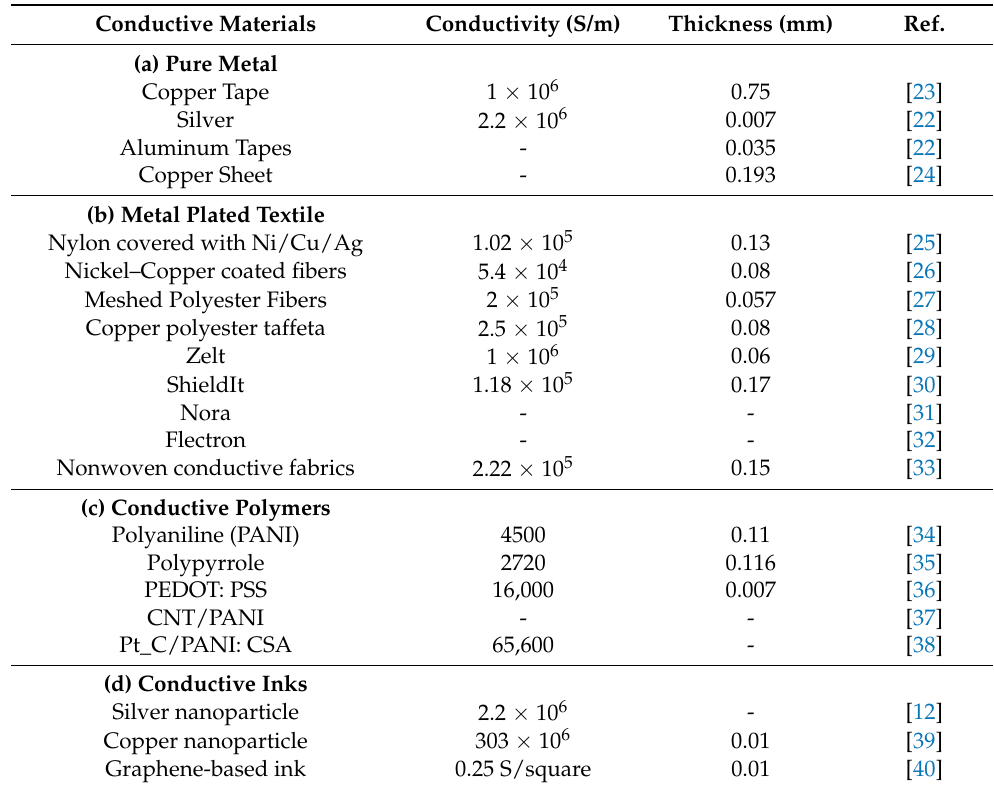
Table 1. Conductive